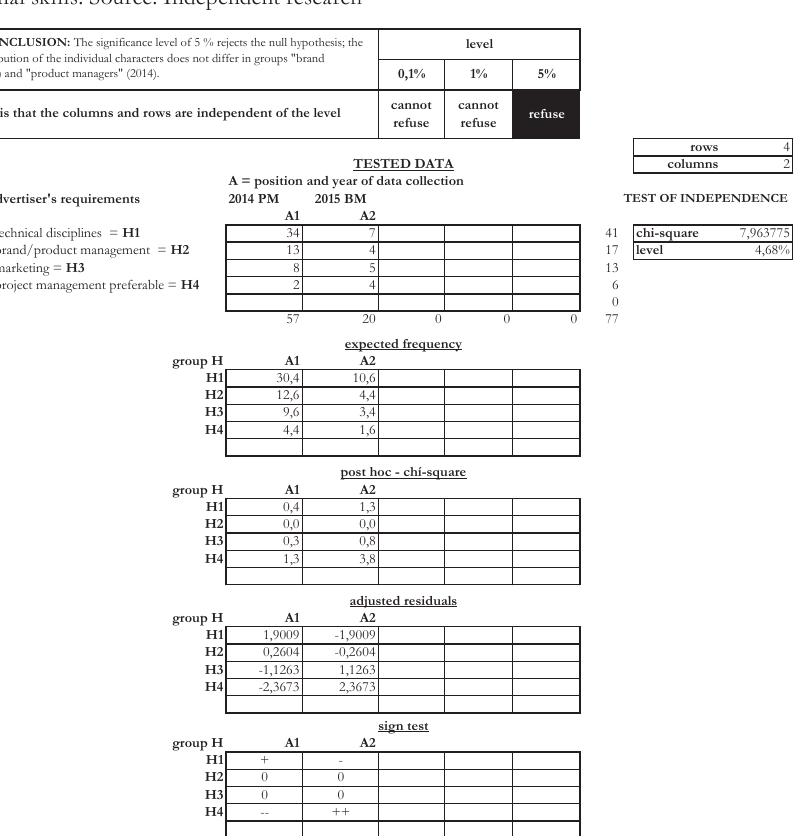
Tab. 4 - Two-dimensional analysis for a group of requirements for technical knowledge